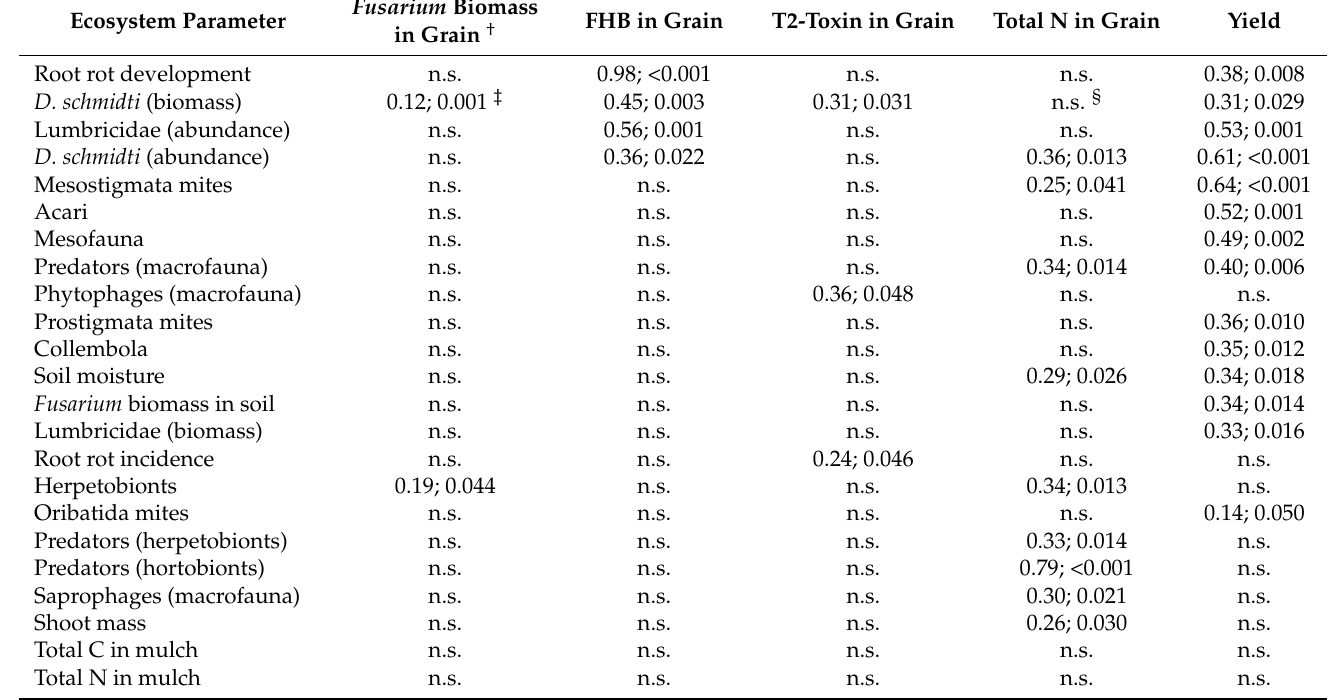
Table 3. Ecosystem parameters associated with FHB related study endpoints assessed by lin- ear